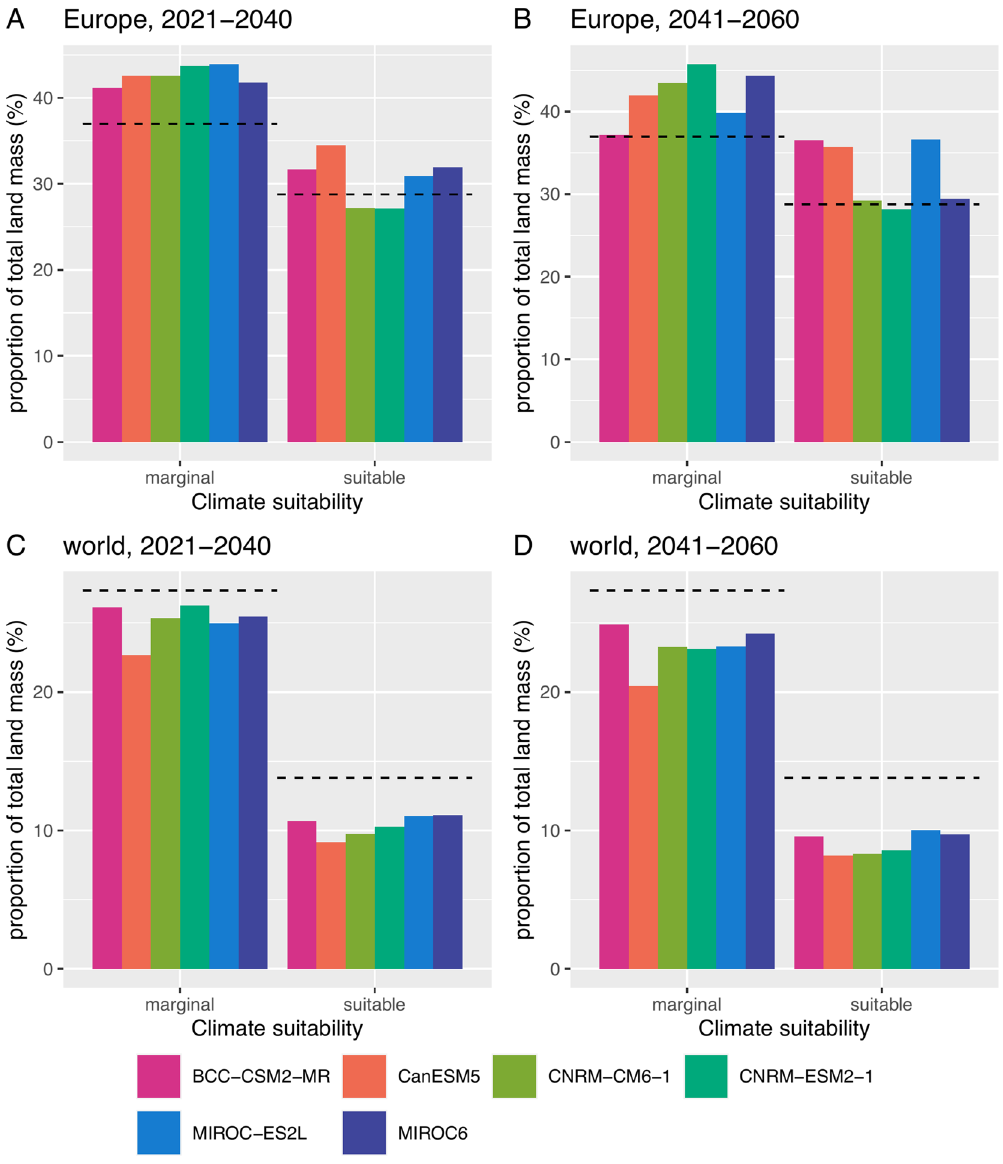
Figure 5. Proportion of total land mass expressed in percentage that are predicted as marginal or suitable according to 6 global circulation models and the shared socio-economic pathways SSP245. ( A ) Estimates for Europe in 2021–2040. ( B ) Estimates for Europe in 2041–2060. ( C ) Worldwide estimation in 2021–2040. ( D ) Worldwide estimation in 2041–2060. Dashed lines indicate the proportion of total land mass for current climate conditions. Europe is delimited by longitudes -15 and 46 and latitudes 34 and 72 decimal